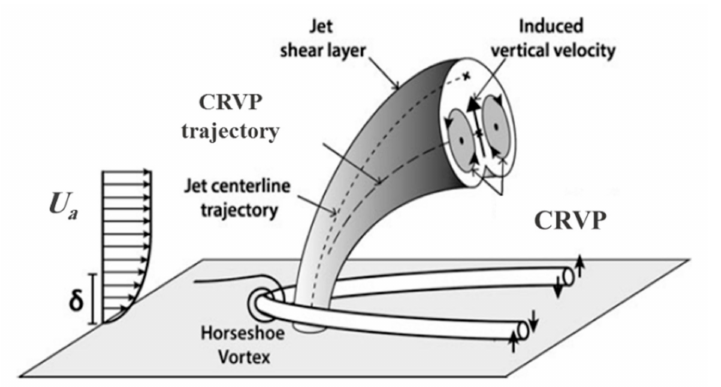
Figure 14. Schematic of the CRVP and jet centerline trajectories in JICF ( δ is the boundary layer thickness)